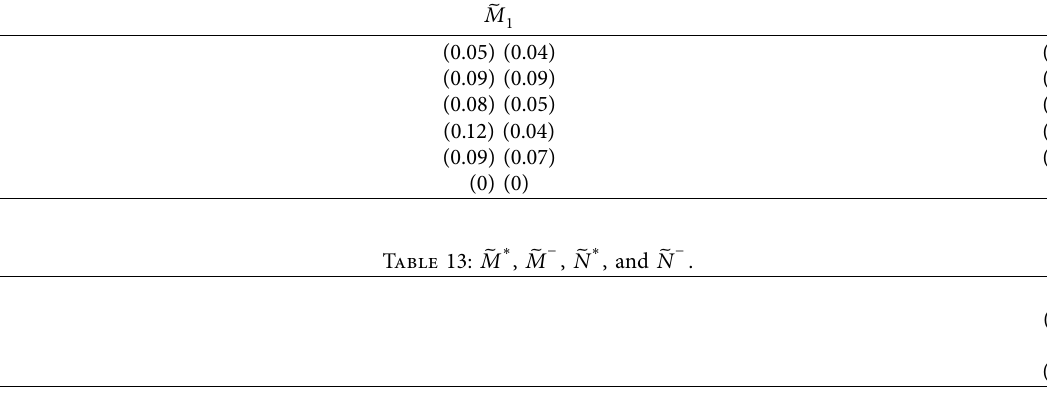
Table 12: Defuzzifcation of 􏽥 M